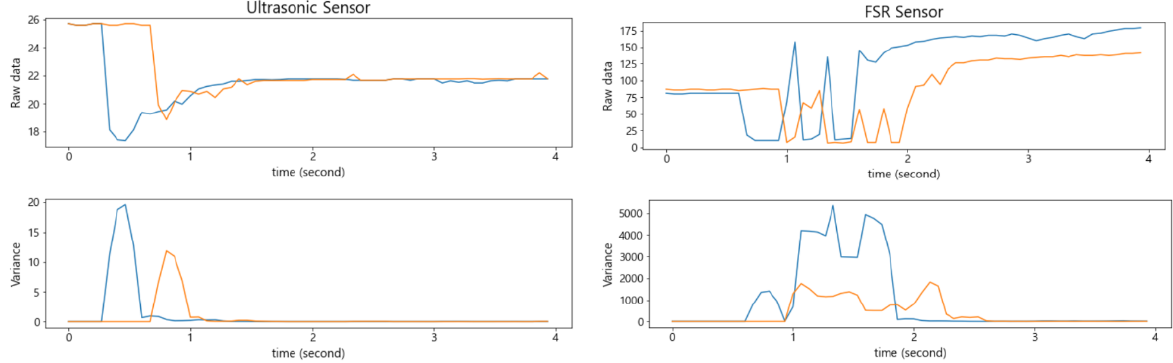
Figure 6. Comparison of the raw data ( top ) and the variance ( bottom ) between the ultrasonic sensor ( left ) and the FSR sensor ( right ).